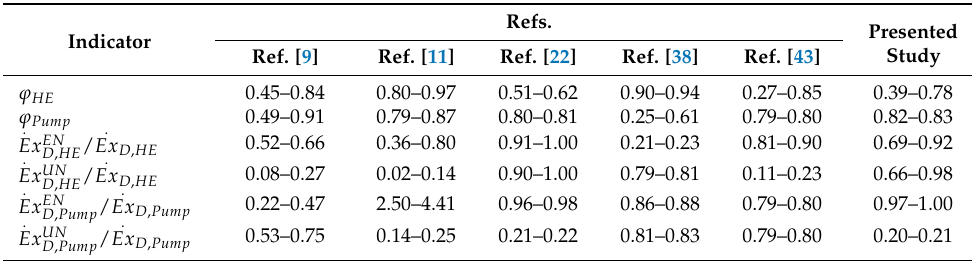
Table 5. Comparison of the exergy performance indicators considering the conducted literature